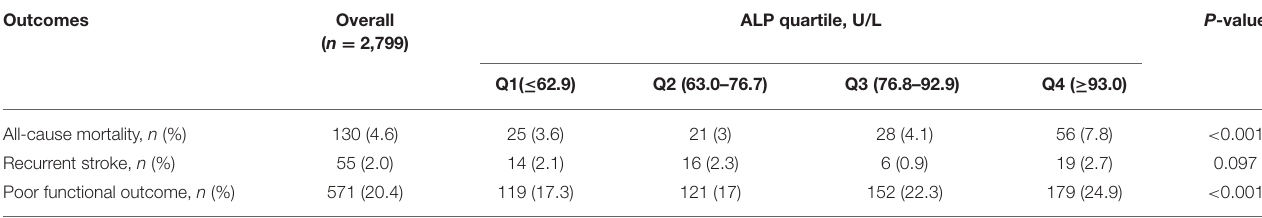
TABLE 2 | Rates of 3-month outcomes according to quartiles of ALP levels.